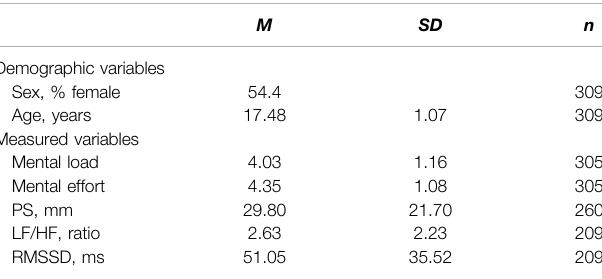
TABLE 1 | Demographic characteristics and measurement